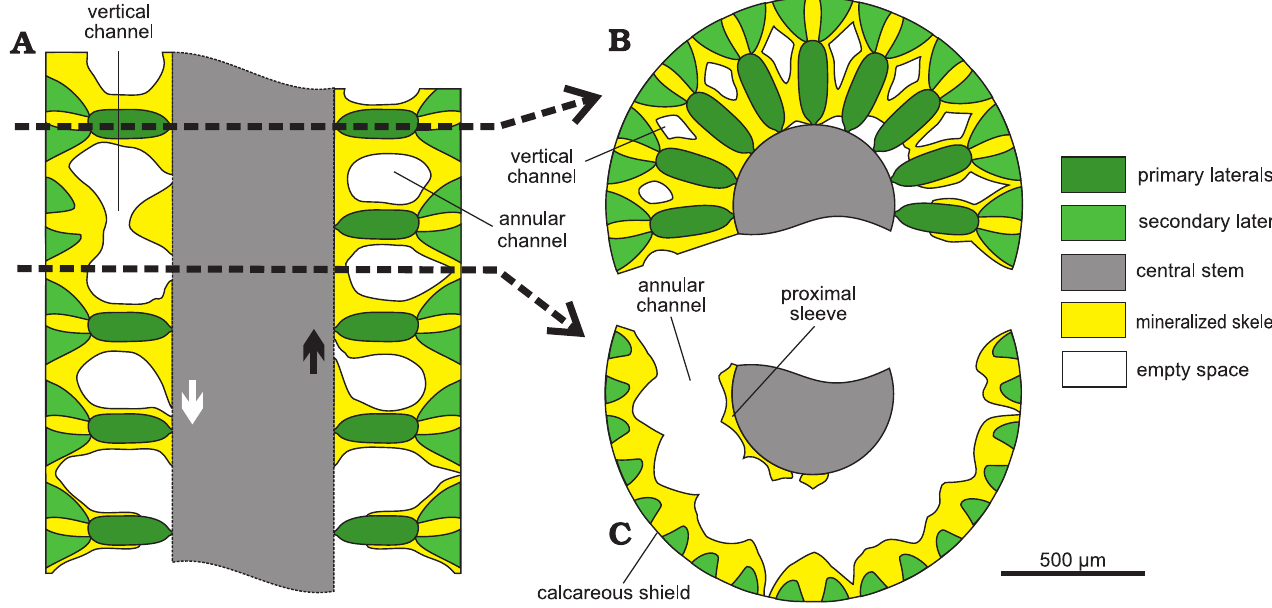
Fig. 5. Scheme of mineralization in dasycladalean alga Chinianella ellenbergeri (Lebouché and Lemoine in Granier and Deloffre, 1994) Granier, Masse and Berthou, 1994, emend. nov. A . Axial section, lowest whorl is weakly calcified. Trace of transverse sections is indicated with dashed lines. B . Transverse section at whorl level. C . Transverse section through the interverticillar space. The interverticillar empty spaces merge laterally (annular channel) and are connected between whorls (vertical channels). A central pore sometimes leaves in contact the interverticillar void and the central cavity, either shifted downwards (white arrow) or upward (black